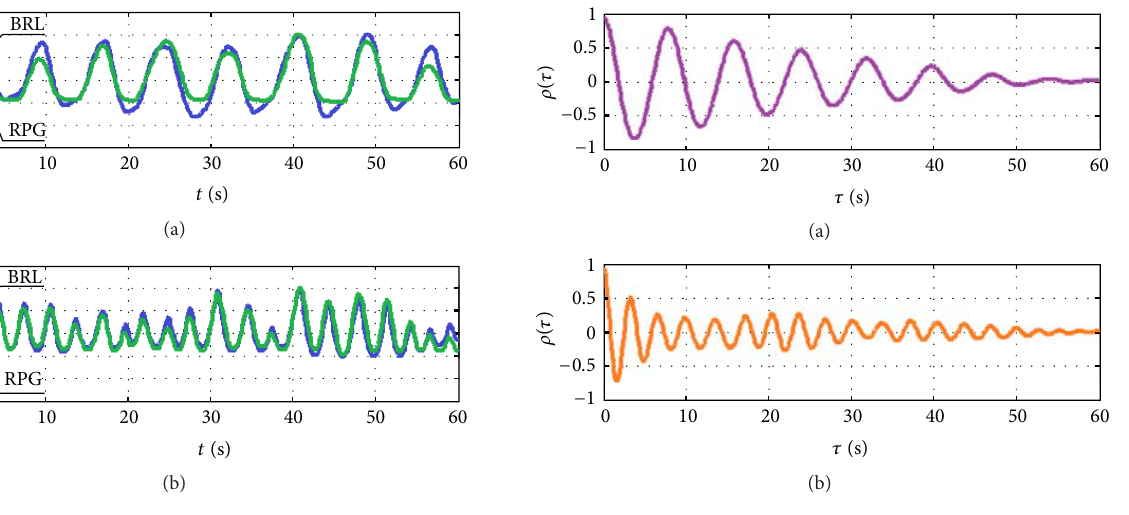
Figure 3: Typical BRL and RPG signals after preprocessing ((a): spontaneous breathing; (b): rapid breathing).